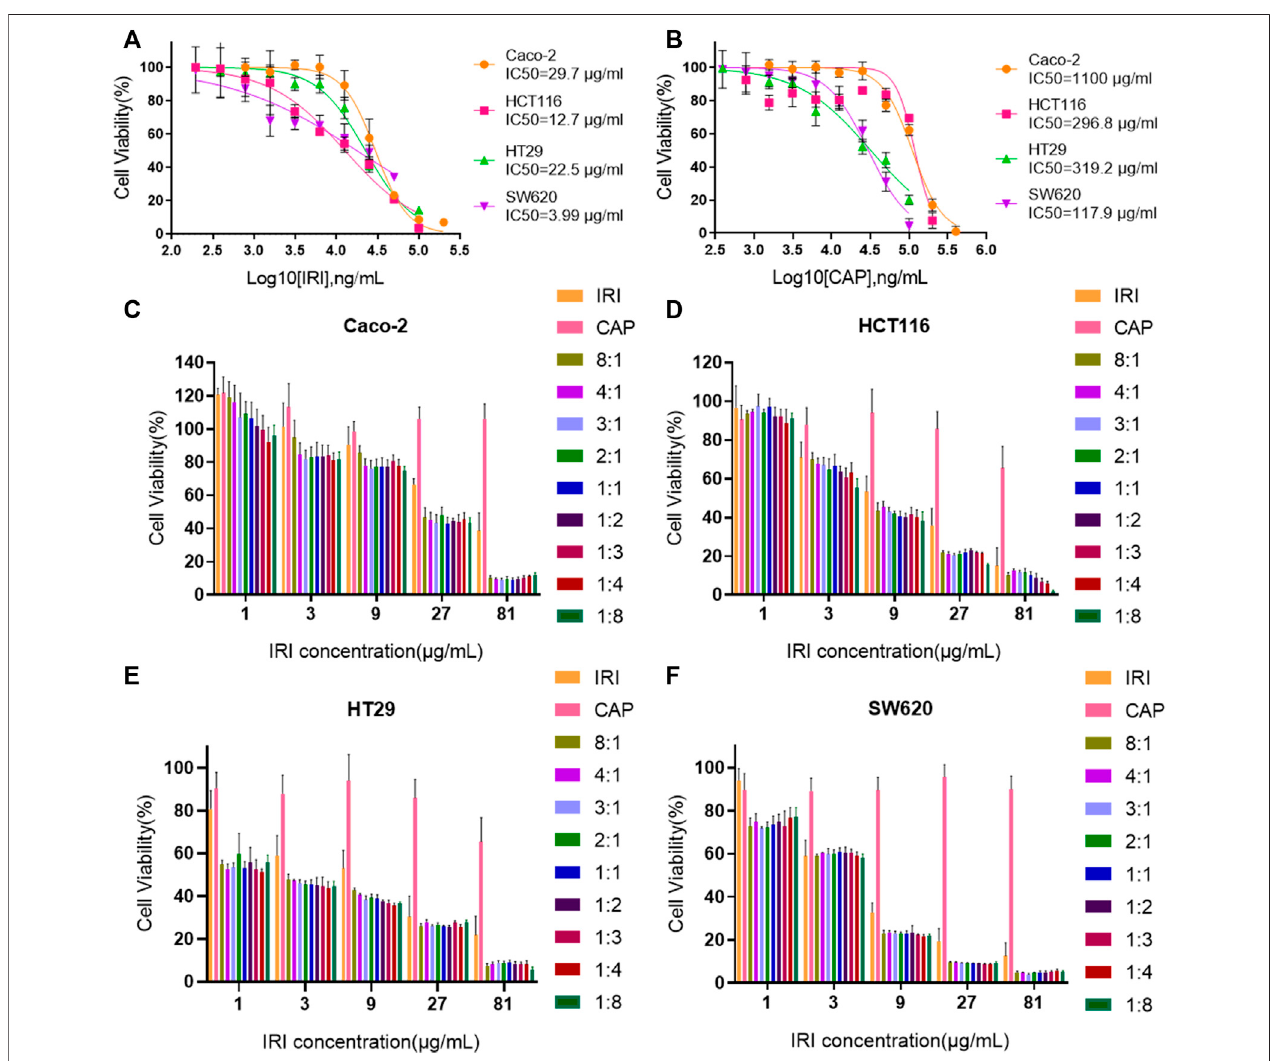
FIGURE2| Theoptimal synergisticratioofirinotecan hydrochloride andcapecitabine was3:1. (A,B) IC50 valueanalysisofCAP andIRIalonein Caco-2, HCT116, HT29, and SW620 cell lines. (C – F) Effect of IRI and CAP on the viability of Caco-2, HCT116, HT29, and SW620 cells at different ratios.